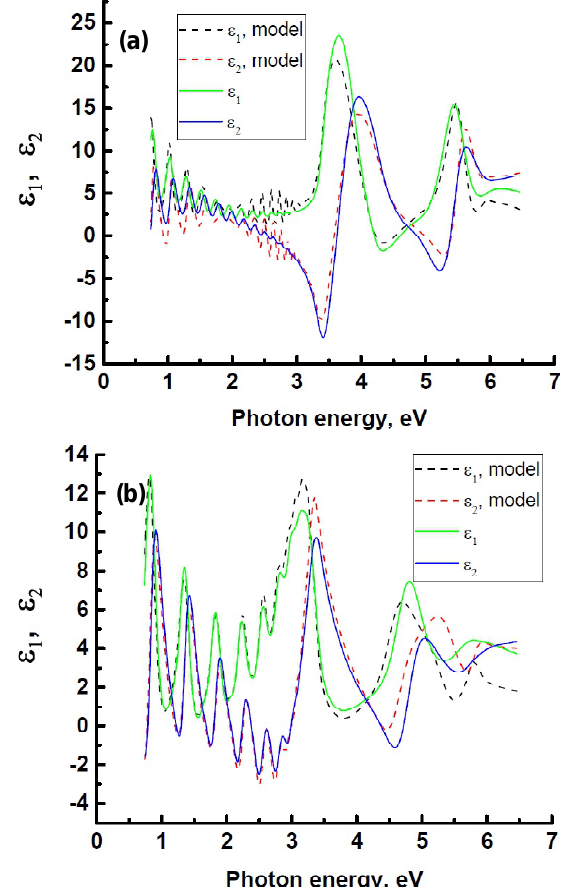
Fig. 11. Dependencies of the dielectric constants of SiC samples on the photon energy.  part of the dielectric constant,  part. The dotted line presents the theoretical de- pendency of  on the photon energy obtained in the framework of the model proposed in [11]; (a) SiC/Si (100) on Fab-1-R-plane sapphire; (b) SiC/Si (111) on Fab-2-C-plane